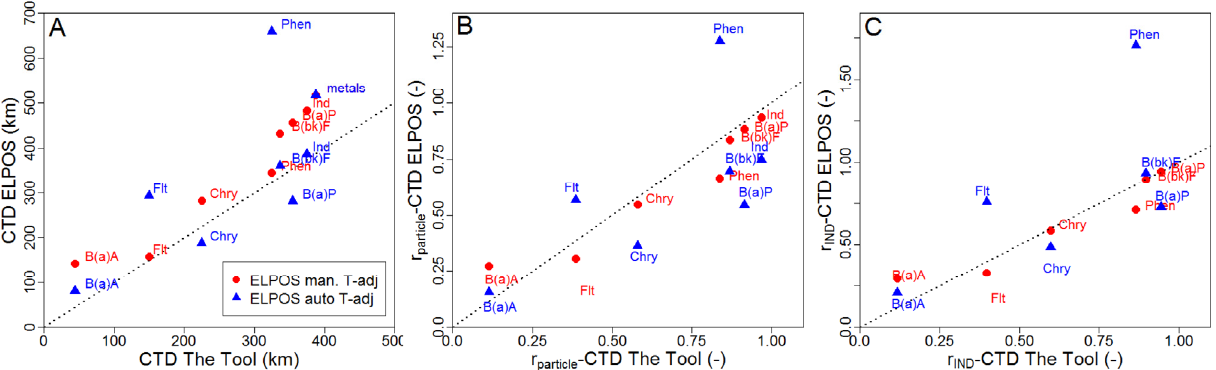
Figure 4. Comparison of characteristic travel distances predicted by The Tool and ELPOS for the average temperature scenario (4 °C). Results from ELPOS were obtained both with the built-in temperature correction of partition coefficients and reaction rates (ELPOS auto T-adj) and with the parameters that were temperature-adjusted manually as in The Tool (ELPOS man. T-adj). ( A ) Absolute CTDs; ( B ) CTDs relative to the particle-CTD; ( C ) CTDs relative to Ind. The 1:1-line is shown as dotted